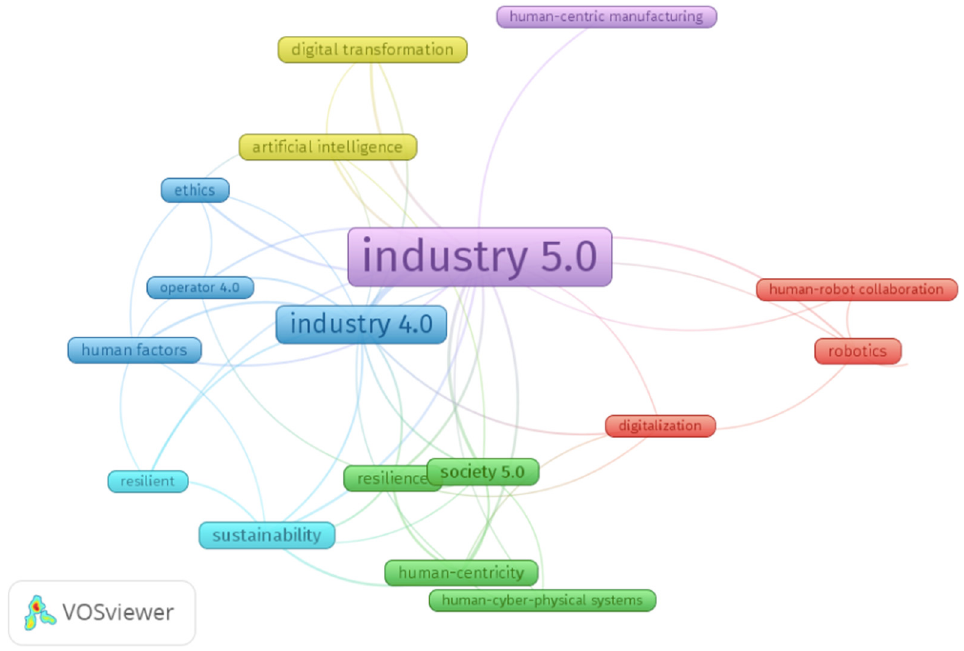
Figure 5. VOSviewer map of the keywords with high occurrence.